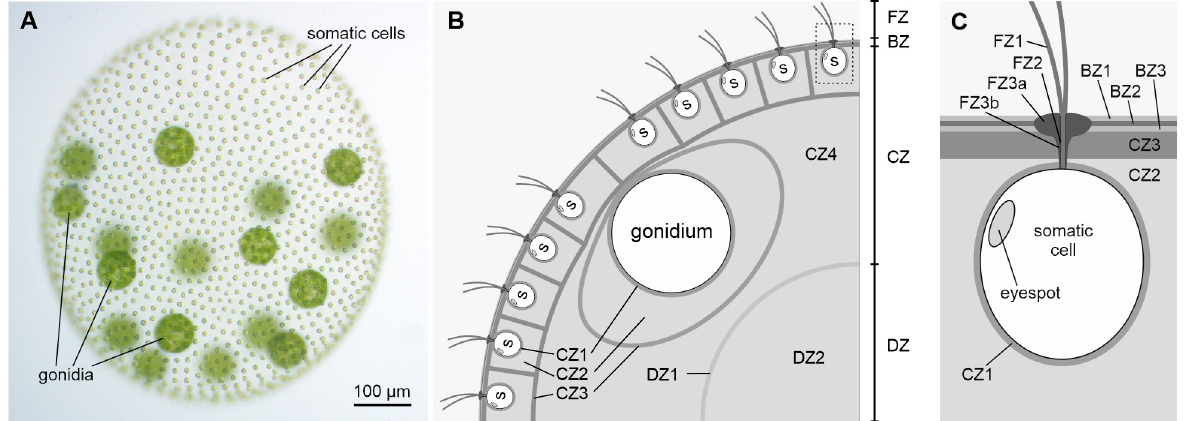
Figure 1. Phenotype and schematic cross section of a V. carteri spheroid illustrating the main zones of the ECM. More than 95% of the volume of a V. carteri spheroid consists of ECM. ( A ) Wild-type phenotype of an asexual, female V. carteri spheroid containing approximately 2000 small, terminally differentiated, biflagellate somatic cells at the surface and approximately 16 large gonidia (reproductive cells) just below the somatic cell layer. ( B ) Schematic cross section. ( C ) Enlarged section of the framed area around a somatic cell in B. ( B , C ) The ECM is divided into deep zone (DZ), cellular zone (CZ), boundary zone (BZ), and flagellar zone (FZ). The deep zone includes the subzones DZ1 and DZ2, the cellular zone has the subzones CZ1, CZ2, CZ3 and CZ4, the boundary zone contains the subzones BZ1, BZ2 and BZ3 and the flagellar zone includes the subzones FZ1, FZ2 and FZ3. FZ3 is subdivided into the flagellar hillock (FZ3a) and the flagellar tunnel wall (FZ3b). FZ2 is also called “flagellar collar”. The ECM structure BZ2 is conserved among volvocine algae; it is also called “crystalline layer” or “tripartite layer”. s, somatic cell.